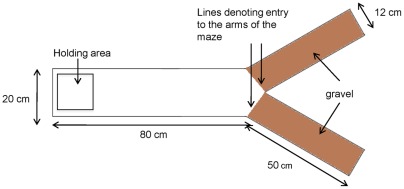
Experimental set-up.